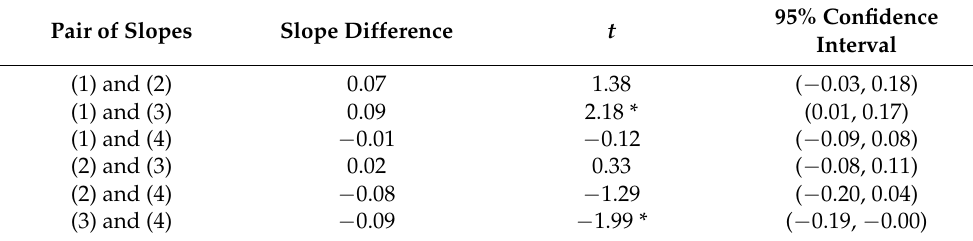
Figure 2. Three-way interaction between general stress, exercise activity during the pandemic, and emotion regulation on energy in men. Table 6. Differences between slopes depicted in Figure 2.